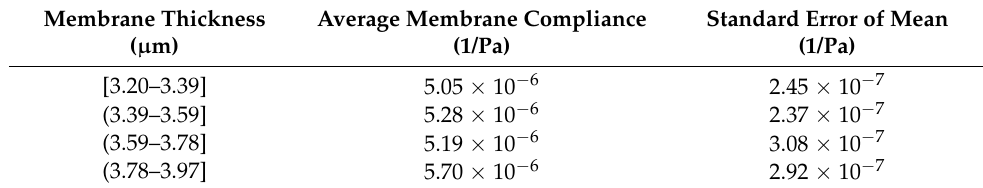
Table 6. Measured compliance values of membranes with different thickness ranges.